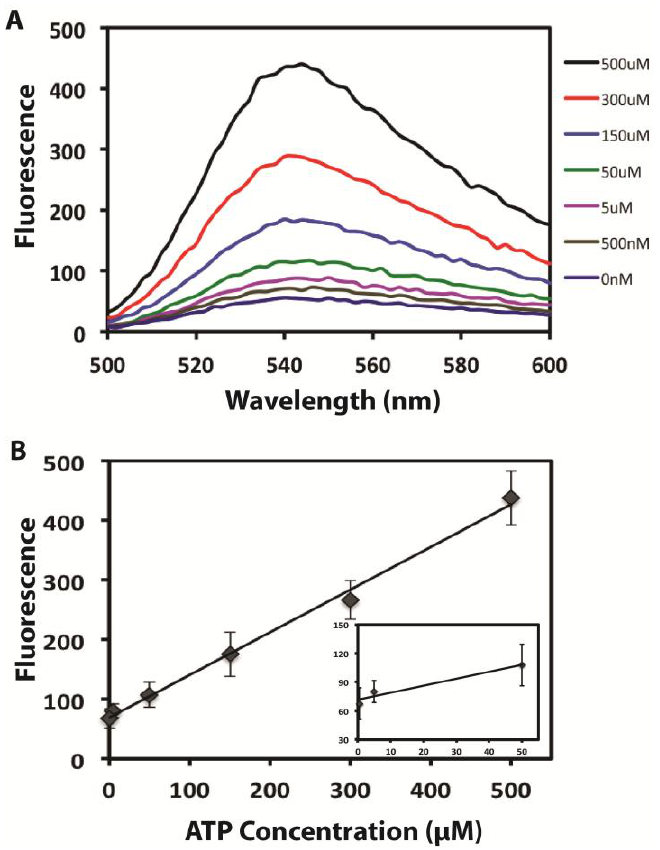
Figure 4. ( A ) Fluorescence-emission spectrum for the amplification aptameric DNA biosensor at a 1 h interval in the presence of different concentrations of target ATP; ( B ) Calibration curve in the standard ATP concentration range of 0.5–500 μM. The inset shows the linearity of the fluorescence response for the sensing system against the low target